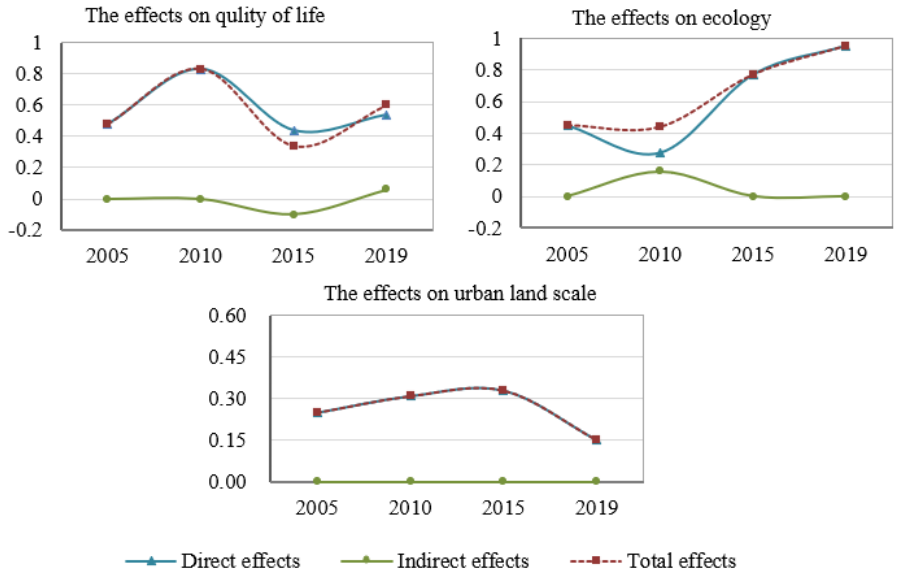
Figure 6. The direct, indirect, and total effects of intensive urban land use on quality of life, ecology, and urban-land-use